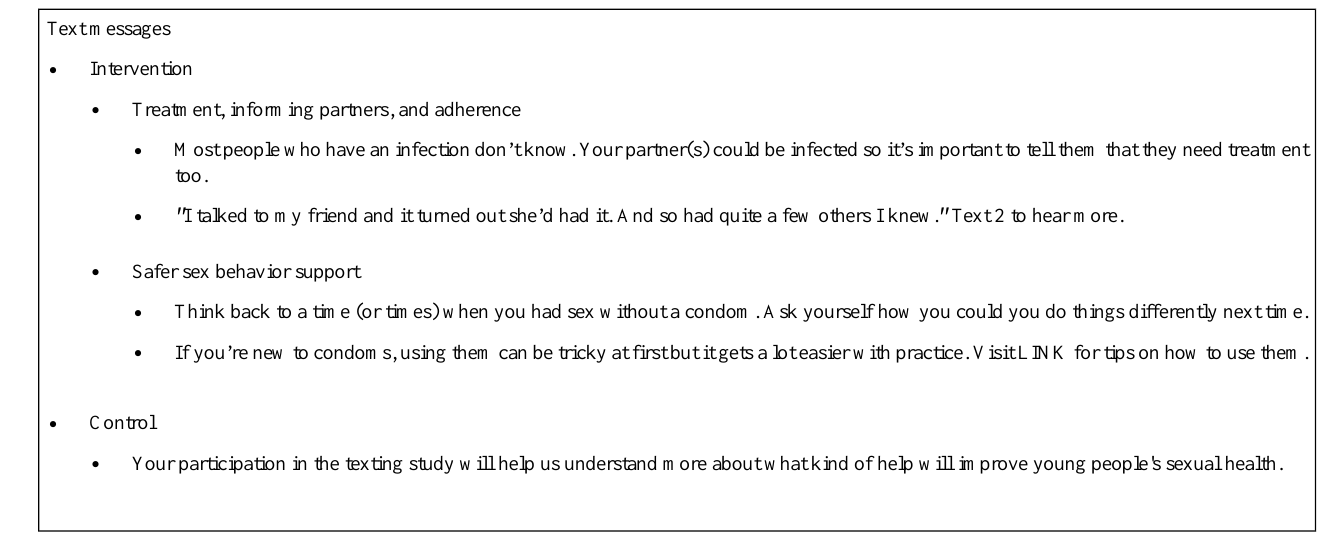
Table 1. Of the participants, 7 females (5 in the intervention group) and 4 males (2 in the intervention group) were diagnosed with a chlamydia infection at enrolment. Another male participant in the intervention group was diagnosed with gonorrhea at